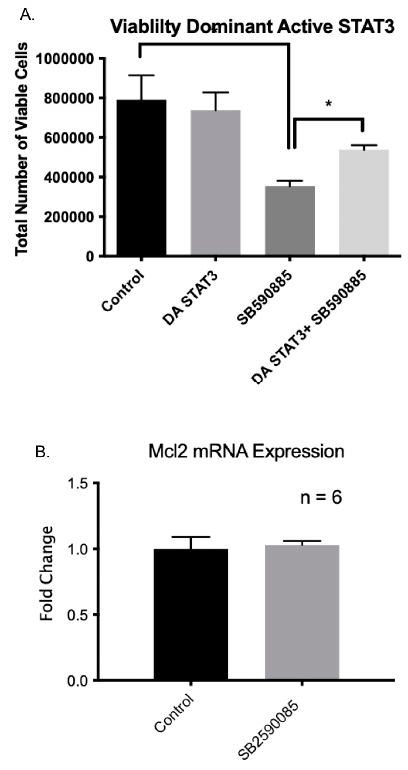
Figure 9. ( A ) The rescue of B-Raf inhibition-mediated apoptosis of VSCs by dominant active STAT3. In addition, dominant active STAT3 itself has no signi fi cant e ff ect on VSCs survival. ( B ) No e ff ect of B-Raf inhibition on Mcl1 mRNA levels in VSCs. * Denotes p < 0.05, n = 5. B-Raf inhibition on Mcl1 mRNA levels in VSCs. * Denotes p < 0.05, n =